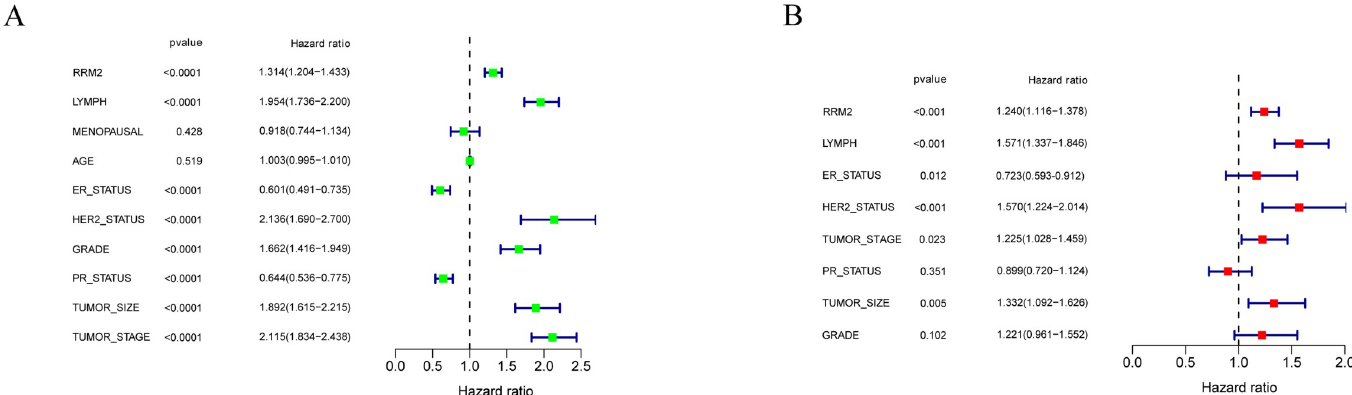
Fig 4. Forest plots showing univariate and multivariate Cox regression analysis of the overall survival of breast cancer patients. RRM2, the number of positive lymph nodes, ER status, Her-2 status, Tumor size, and Tumor stage were significantly correlated with overall survival (P < 0.05). (A): Univariate Cox analysis. (B): Multivariate Cox